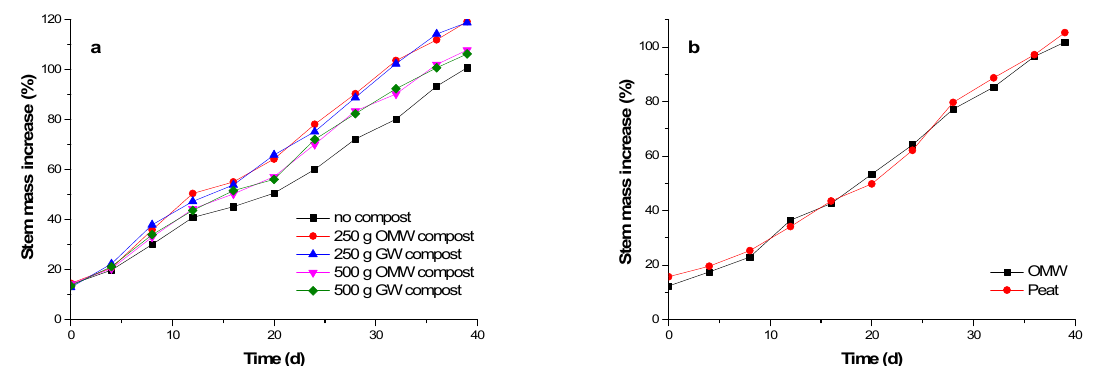
Figure 7. Comparison of stem mass increase in ( a ) vegetables, ( b ) flowers for real field application experiments.